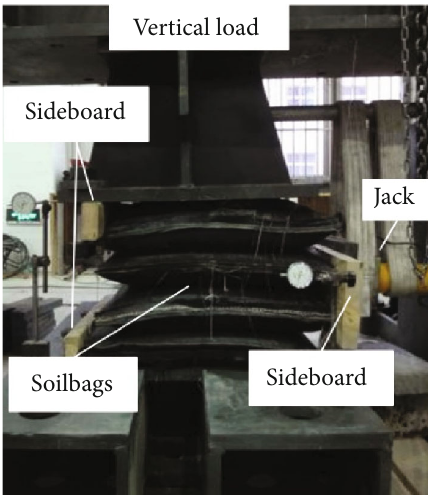
Figure 5: Shearing experiment of the soilbags.